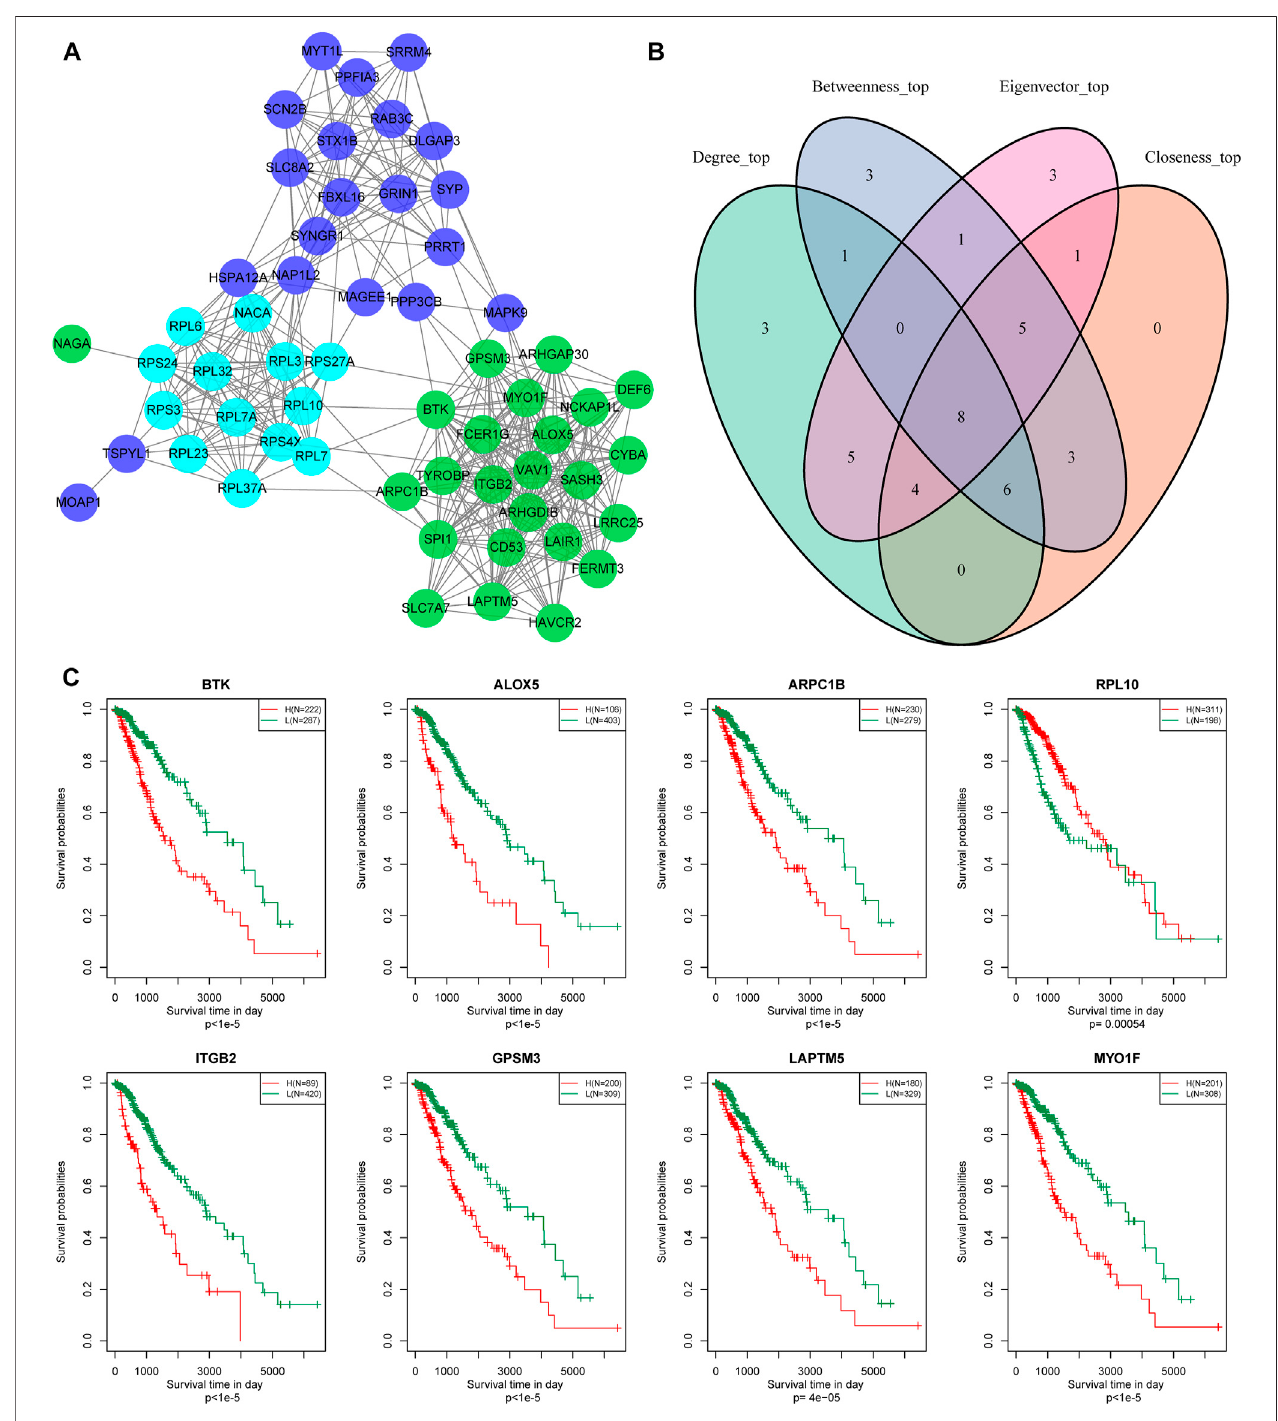
FIGURE 8 | Hub genes identi fi cation of metabolic co-expressed gene module. (A) The protein interaction network between the key genes of the modules; the differentcolorsofthenetworknodesindicatedifferentmodules. (B) Venndiagramofkeygenes. (C) Kaplan-Meierprognosticcurveofmarkergenesrelatedtometabolic subtype feature